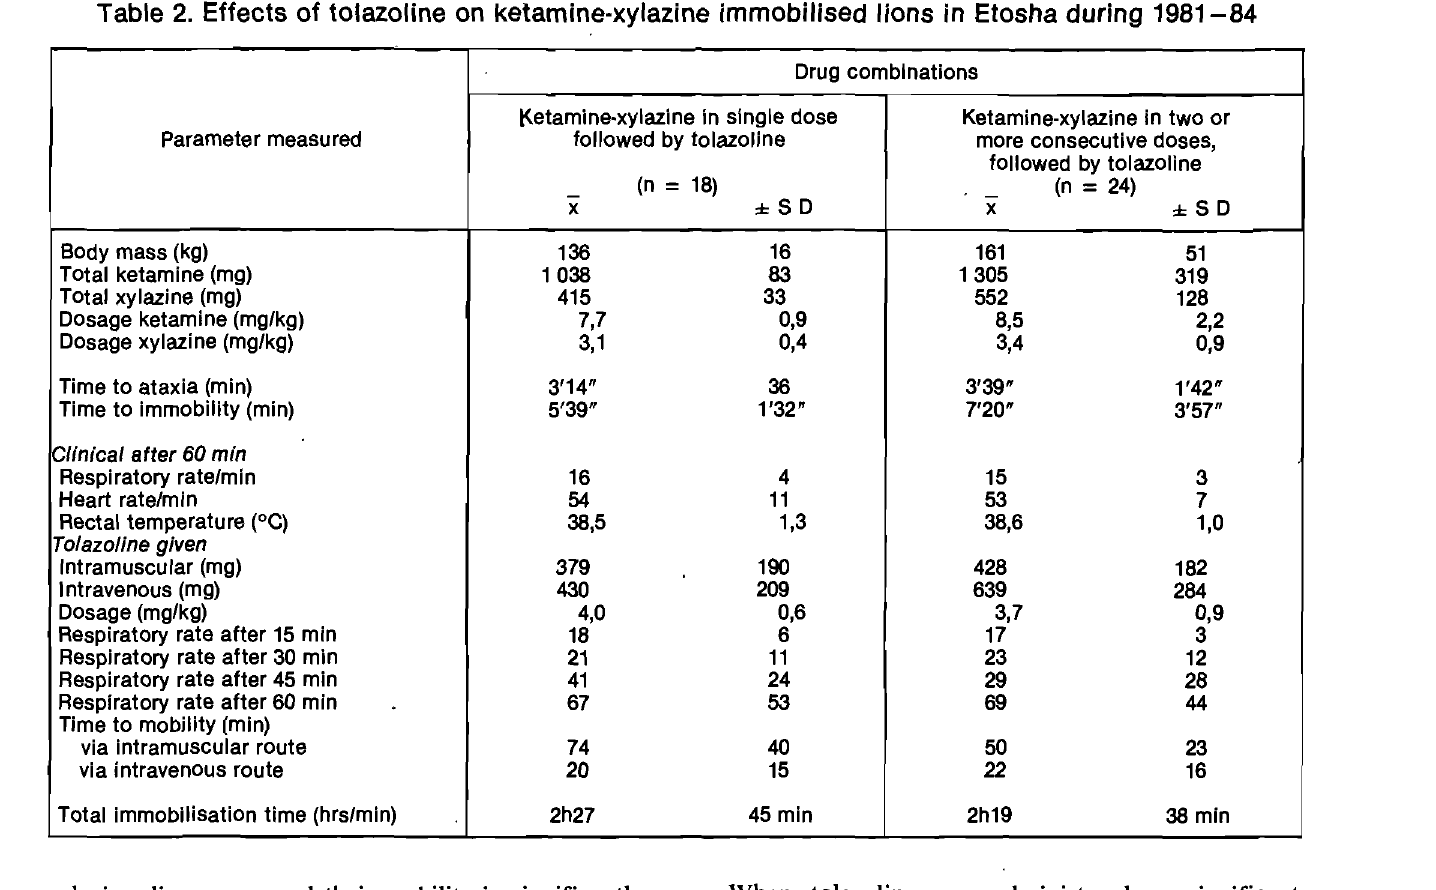
Table 2. Effects of tolazoline on ketamine-xylazine immobilised lions in Etosha during 1981-84 Drug combinations Ketamine-xylazine in single dose Ketamine-xylazine in two or Parameter measured followed by tolazoline more consecutive doses, followed by